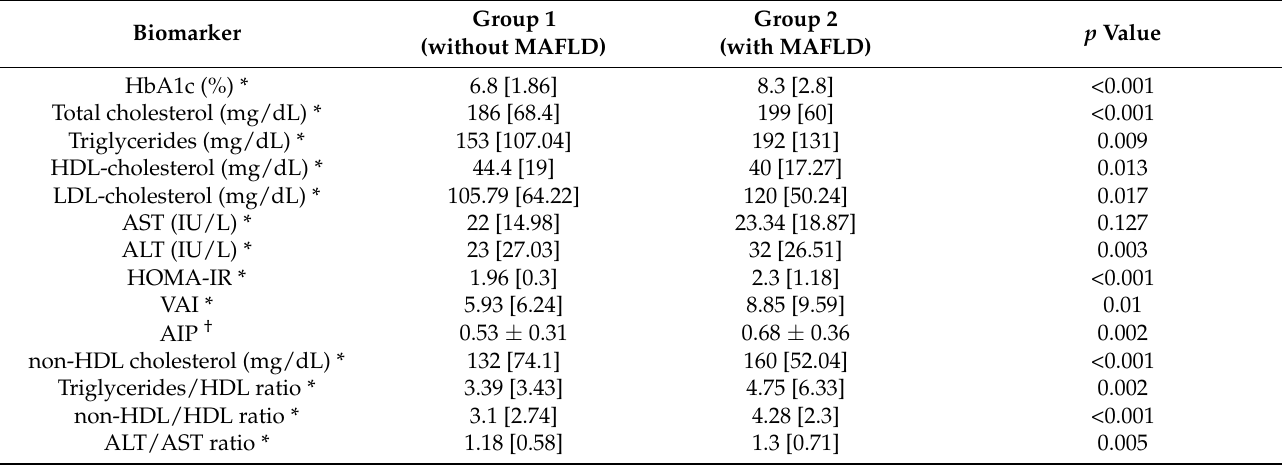
Table 2. Biomarkers associated with